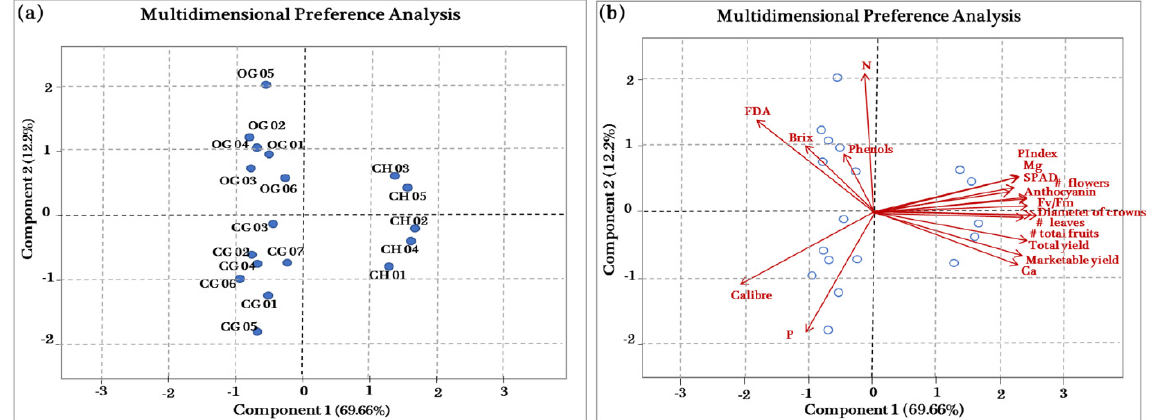
Figure 6. Results of the principal component analysis (PCA): projection of biostimulant treatments in the greenhouse and under the high tunnel ( a ), factor loadings for variables ( b ); soil microbial activity (FDA), performance index (PI), maximum quantum efficiency of photosystem II (Fv/Fm), chlorophyll content (SPAD), number of leaves (# leaves), number of flowering stalks (# flowers), diameter of crowns (Diameter), nitrogen (N), potassium (K), phosphorus (P), calcium (Ca), magnesium (Mg), total weight of fruits (Total yield), total number of fruits (# fruits), weight of marketable fruits (Marketable yield), fruit size (Calibre), total soluble sugars (Brix), total polyphenols (Phenol), and copper (Cu), and anthocyanin content (Antho).